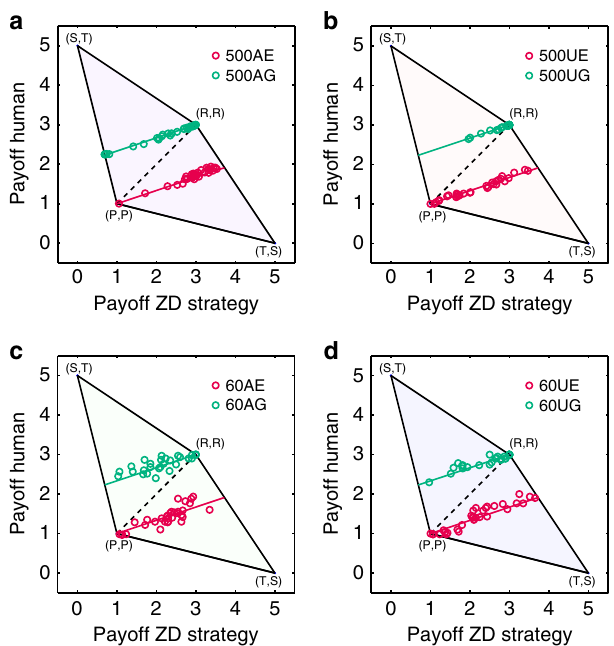
Figure 4 | Experimental scores and theoretical prediction. For 500-round treatments ( a , b ) and 60-round treatments ( c , d ), the shaded area depicts the space of possible scores for the ZD strategy implemented by the ZD strategist ( x -axis) and the human co-player ( y -axis). The red (green) line corresponds to the theoretical prediction of the expected scores of extortion (generosity), respectively. For Extortion, the ZD strategist’s score s e and his human co-player’s score s e satisfy s e z (cid:2) 1 ¼ 3 (red line), and the z h s e h (cid:2) 1 maximum scores for the ZD strategist and the human co-player are 3.727 and 1.907, respectively, while the minimum scores for both the ZD strategist and the human co-player are 1. For Generosity, the ZD strategist’s score s g and his human co-player’s score s g satisfy s g z (cid:2) 3 ¼ 3 (green line), and z h s g h (cid:2) 3 the maximum scores for both the ZD strategist and the human co-player are 3, while the minimum scores for the ZD strategist and human co-player are 0.692 and 2.232, respectively. The open red (green) circles indicate the outcome of the extortionate (generous) treatment, respectively. Each circle indicates a pair of scores, the horizontal axis representing score of the ZD strategist and the vertical axis representing the human co-player’s score. Corresponding to each line, there are 32 player pairs (circles) for each treatment (for individual level scores see Supplementary Tables 3 and